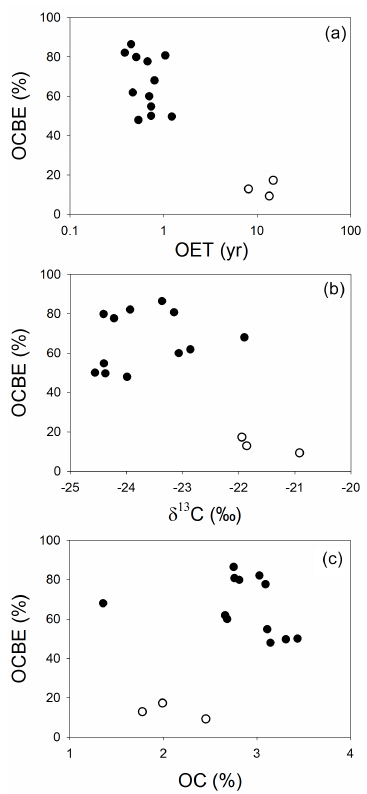
Figure 3. Relationships between OC burial efficiency (OCBE) and (a) oxygen exposure time (OET), (b) OC isotopic composition of top sediment ( δ 13 C) and (c) OC content in the top sediment. In all cases, the analysis of pelagic sites alone (closed circles) re- sulted in non-significant correlations (Spearman; OET: r = − 0 . 47, p = 0 . 12; δ 13 C: r = − 0 . 30, p = 0 . 33; OC: r = − 0 . 53, p = 0 . 07). If margin sites (open circles) are included, the correlation between OCBE and OET becomes significant ( r = − 0 . 72, p = 0 . 002).